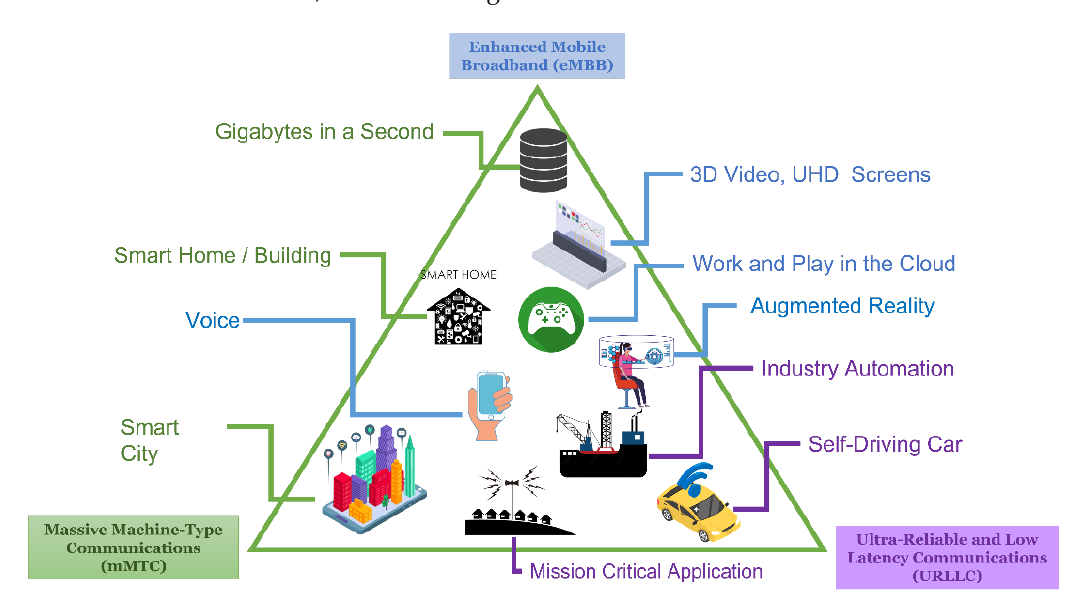
Figure 2. IMT scenarios for 2020 and beyond. Source: [7,29,30].